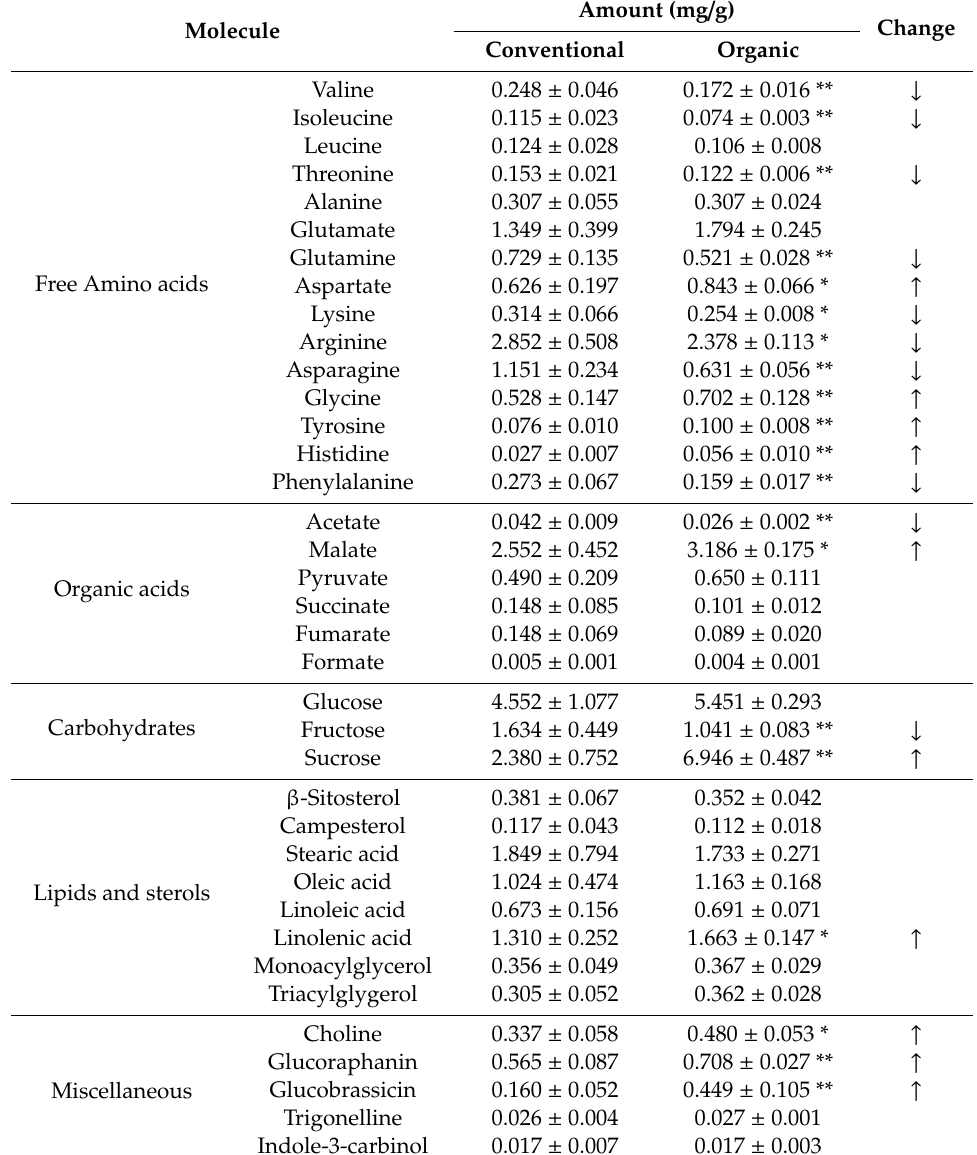
Table 2. Composition of B. Oleracea var. italica determined by NMR